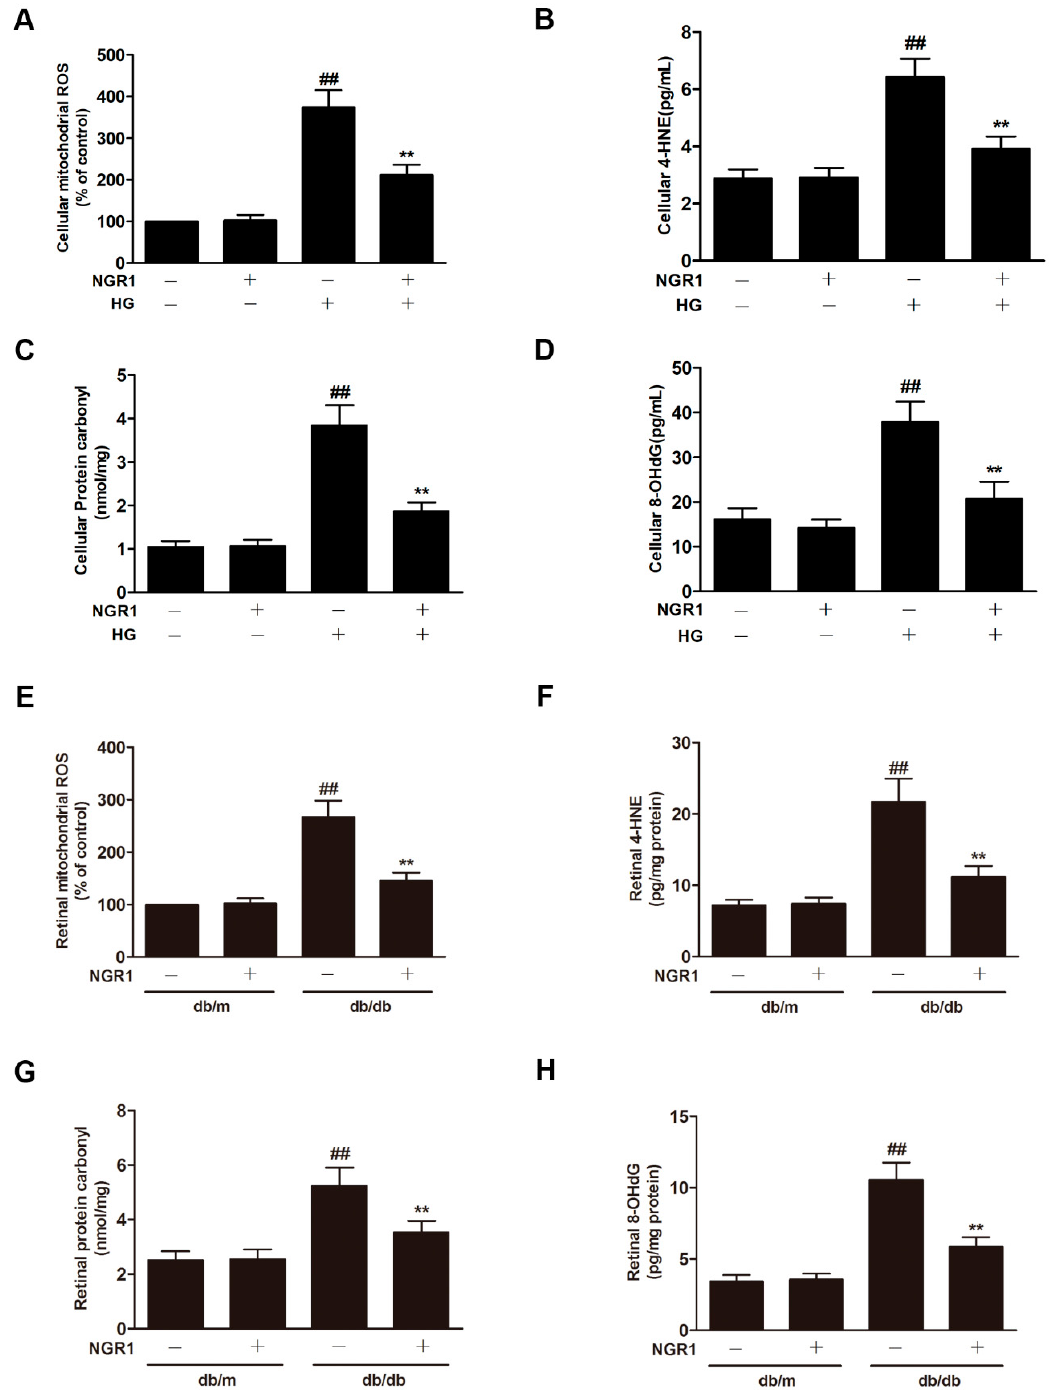
Figure 5. NGR1 pretreatment significantly suppressed oxidative stress in vivo and in intro. NGR1 preconditioning significantly suppressed HG-induced mitochondrial ROS production ( A ) and the production of 4-HNE ( B ), protein carbonyl ( C ), and 8-OHdG ( D ) in rMC cells. NGR1 pretreatment significantly decreased the level of mitochondrial ROS ( E ), 4-HNE ( F ), protein carbonyl ( G ), and 8-OHdG ( H ) in the retina of db/db mice. The level of mitochondrial ROS was determined by MitoSOX™. The production of 4-HNE, protein carbonyl, and 8-OHdG in rMC cells was detected by ELISA. The results are expressed as the means ± SD (n = 10). ## indicates a significant difference from the control cells or db/m mice ( p < 0.01). ** indicates a significant difference from HG treatment or db/db mice ( p < 0.01). (+), treatment with HG or NGR1; ( − ), treatment without HG or NGR1.